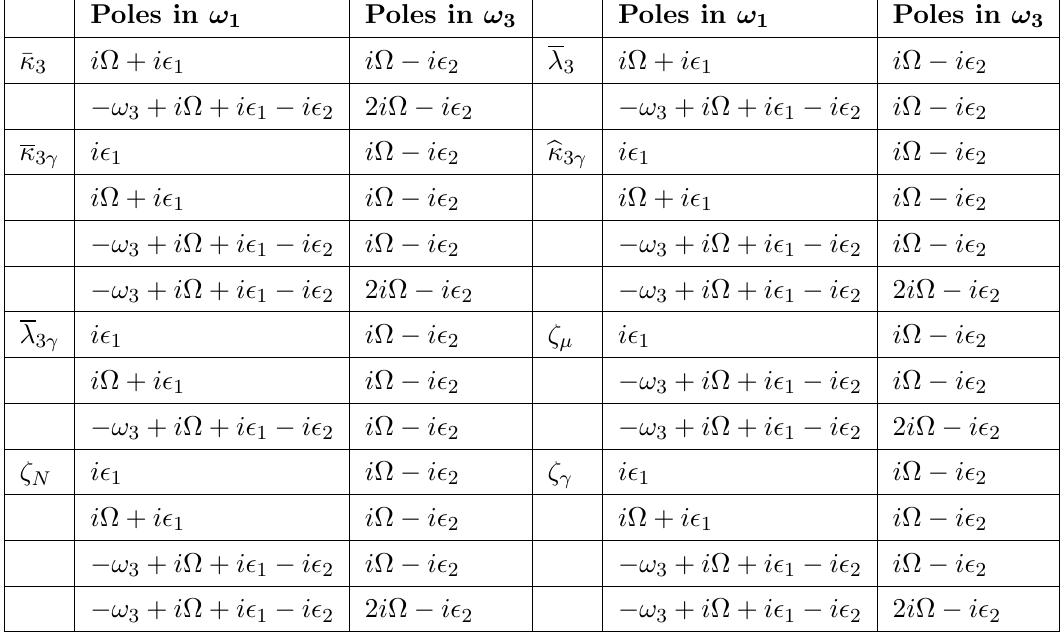
Table 8 . Poles for determining cubic